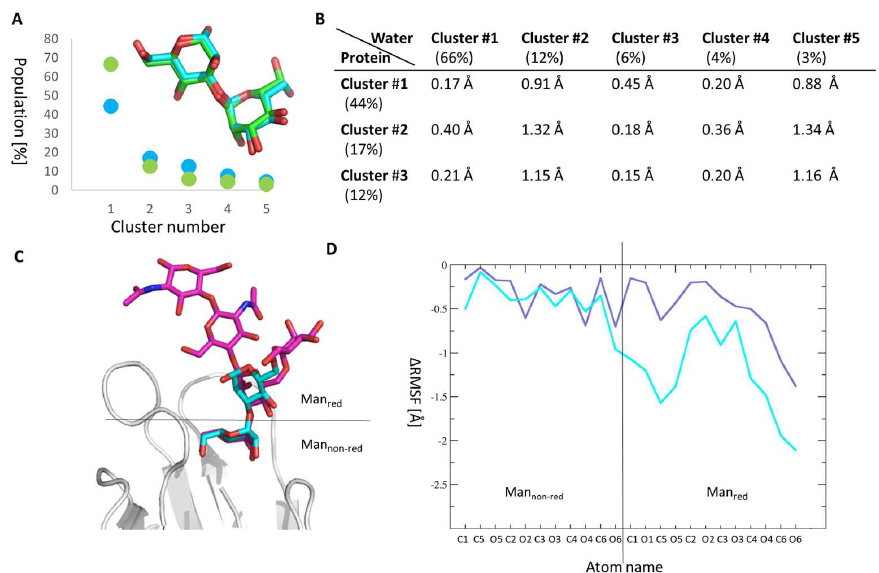
Figure 4. Molecular details of Man α 1,3Man binding to FimH. ( A ) Clusters featuring similar structures were extracted from the MD simulations of Man α 1,3Man in the FimH binding site (cyan) and in water (green) and plotted against their population occurrence (in %). Only the five highest ranking clusters are depicted, which account to 89% and 86% of the conformations in water and in the protein, respectively. As an inlay the superposition of the representative structure from cluster #1 in the protein (cyan) and in water (green) is shown. ( B ) RMSD values between the representative conformation of each cluster in water and in the protein. ( C ) Overlay of the presentative structure of Manα1,3Man (cyan) in cluster #1 of the Manα1,3Man·FimH complexes against the Oligomannose-3 (magenta) in its crystal structure (PDB ID: 2VCO). ( D ) The difference in root mean square fluctuations (ΔRMSF) is between the Manα1,2Man (lilac) and Manα1,3Man (cyan) in water and inside the FimH binding site is plotted against the atom name of the dimannose. The position of the first and second mannose ring in FimH is highlighted in the protein structure in ( C ).